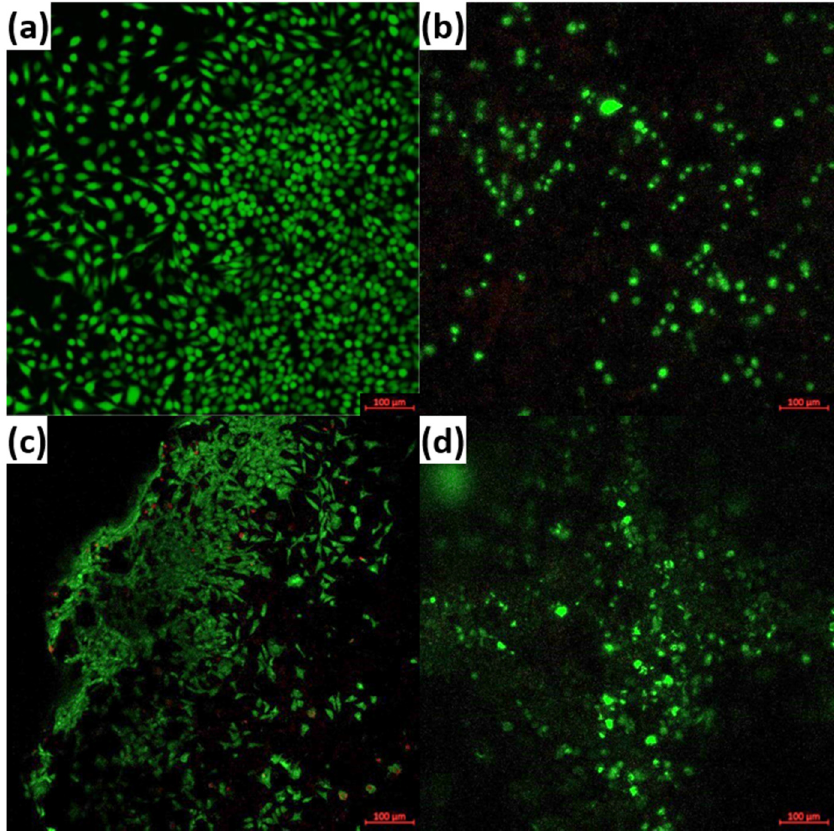
Figure 9. Representative fluorescence images for the synthesized scaffolds in contact with fibroblast cells for 7 days: ( a ) Control, ( b ) Ce-1000, ( c ) Sm-1000 and ( d ) Sr-1000.